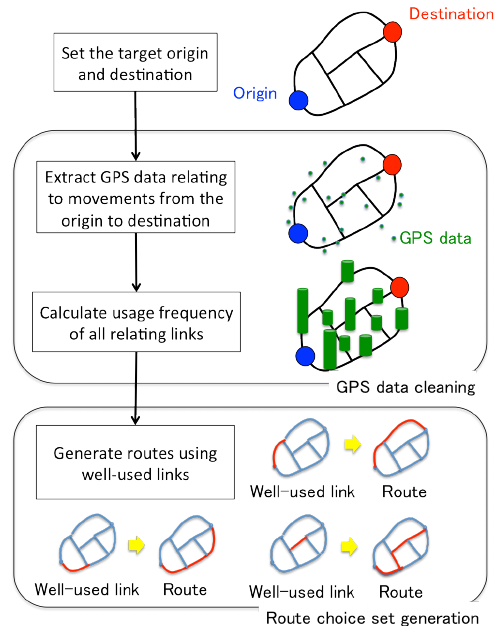
Figure 1. Schematic diagram of the proposed approach